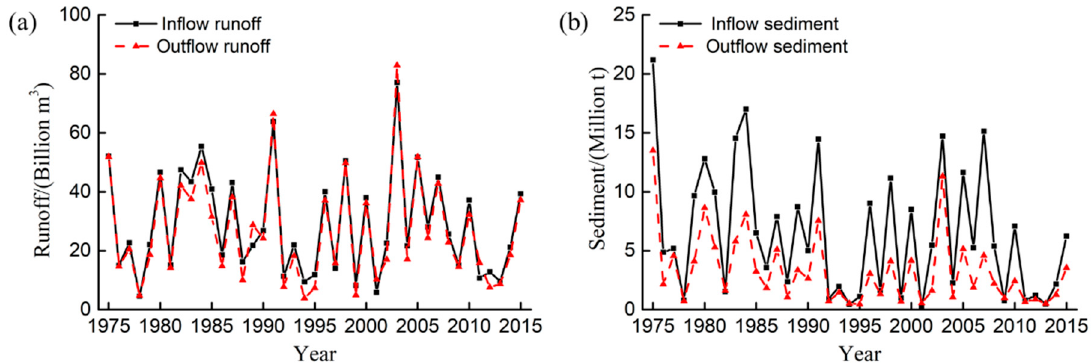
Figure 2. The runoff and sediment time series flowing into and out of Hongze Lake from 1975 to 2015. ( a ) Runoff time series; ( b ) Sediment time series.